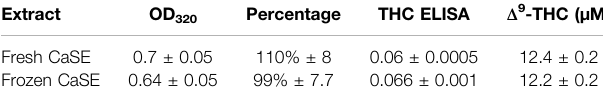
TABLE 3 | Δ 9 -THC absorbance (OD 320 ) and estimated concentration by ELISA.